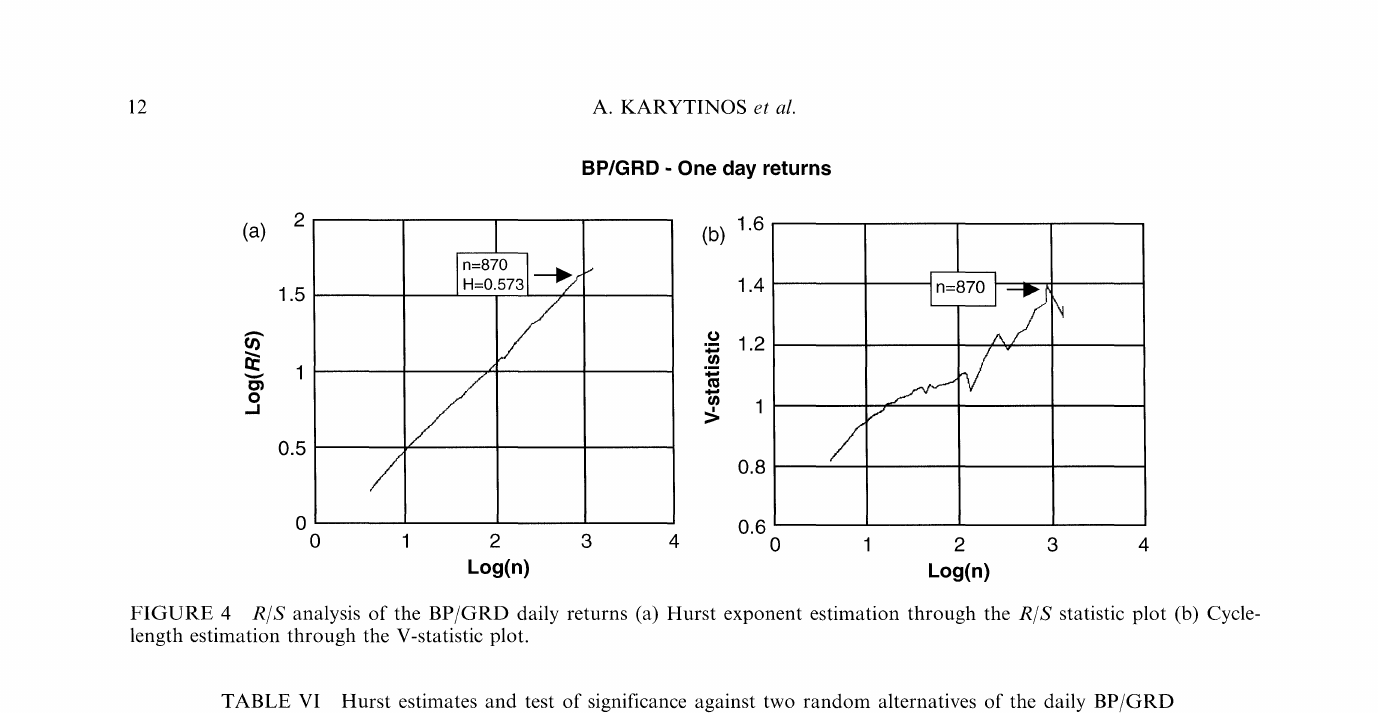
FIGURE 4 R/S analysis of the BP/GRD daily returns (a) Hurst exponent estimation through the R/S statistic plot (b) Cycle- length estimation through the V-statistic plot. TABLE VI Hurst estimates and test of significance against two random alternatives of the daily BP/GRD returns A. R/S analysis results